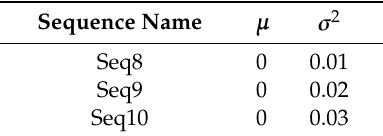
Table 2. Description of sequence 8–10. Table 2 . Description of sequence 8–10.